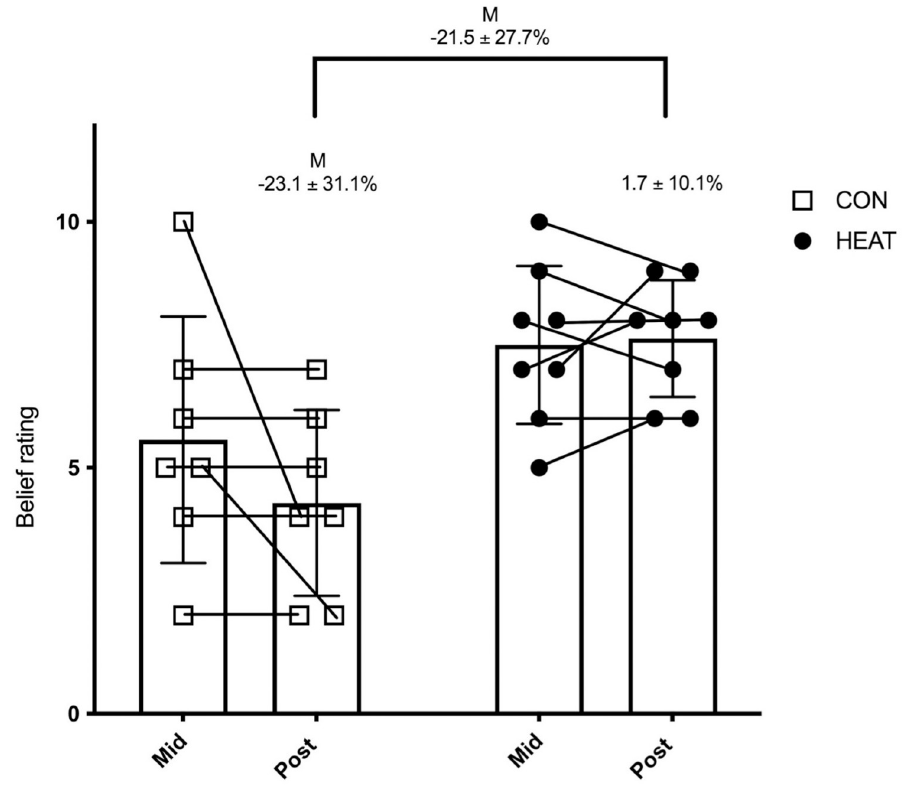
Fig 4. Belief (mean ± SD) that in-game running performance increased in HEAT and CON at mid and post- intervention time points. Within-group changes are indicated above the respective post-value and above those is the between-group comparison of change. All comparisons are expressed as mean ± 90% confidence intervals. Letters depict effect size (d); M (moderate).